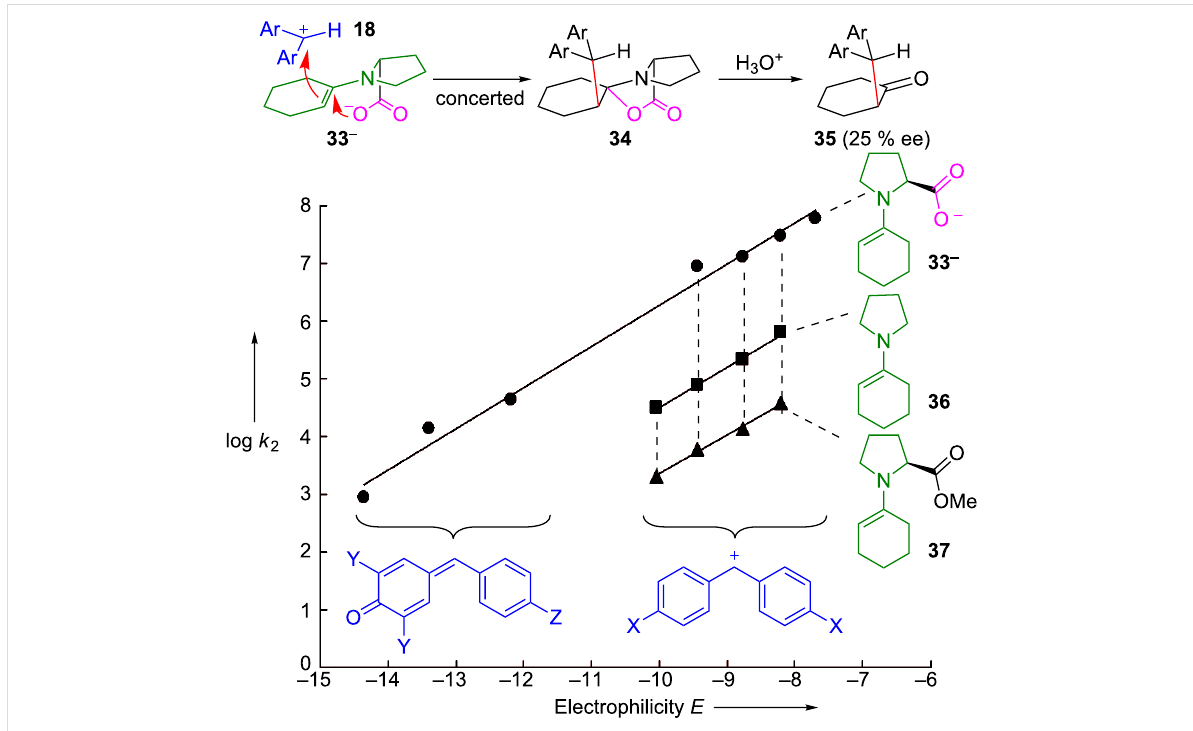
Figure 21: Kinetic evidence for the anchimeric assistance of the electrophilic attack by the carboxylate group . The hydrolysis product ( R )- 35 was obtained with 25% ee from the reaction of 33 − (counterion: protonated DBU) with 18a -BF 4 − (Ar = 4-Me 2 N-C 6 H 4 ) in MeCN after aqueous workup [92].